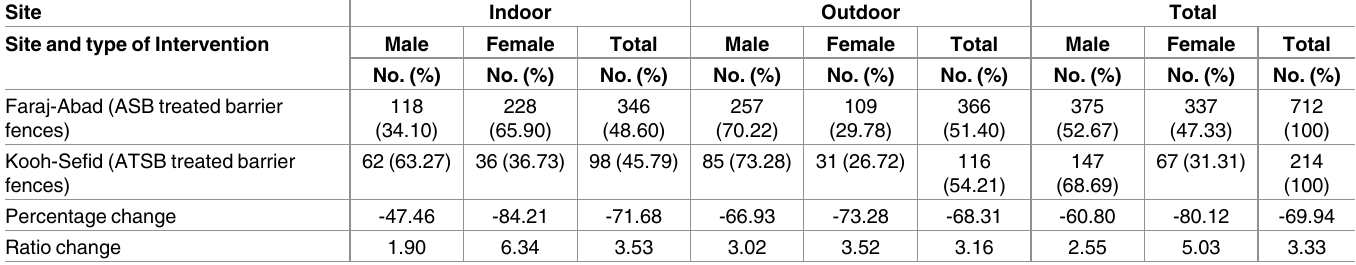
Table 6. The comparison of P . papatasi frequency indoors and outdoors of Kooh-Sefid and Faraj-Abad using sticky traps (ATSB and ASB-treated barrier fences), Markazi district, Qom province, 2015. Site Indoor Outdoor Total Site and type of